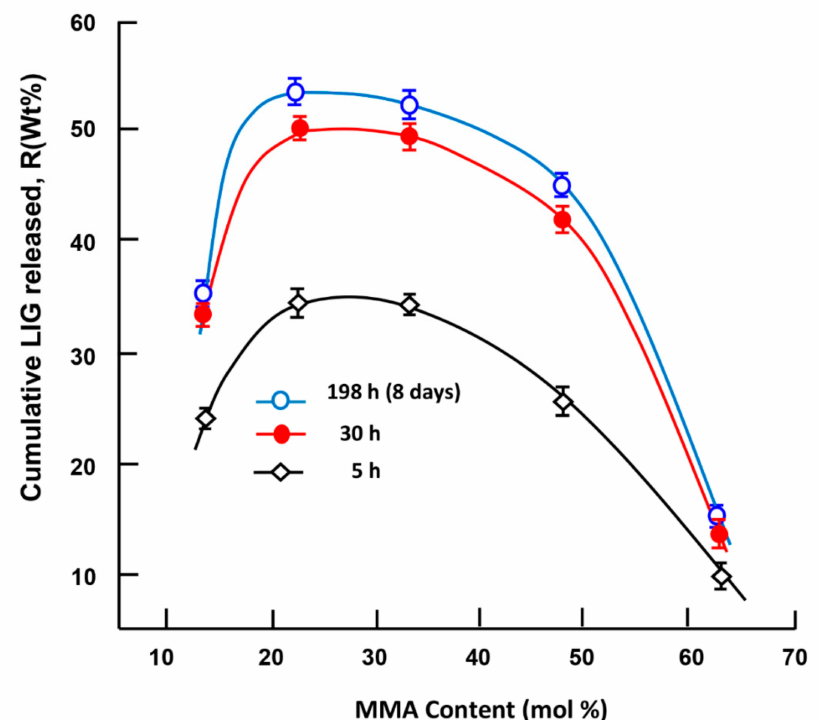
Figure 14. Variation of the cumulative LIG released from the PHEMMAC / LIG system versus the MMA content taken during 5, 30, and 198 h of the release